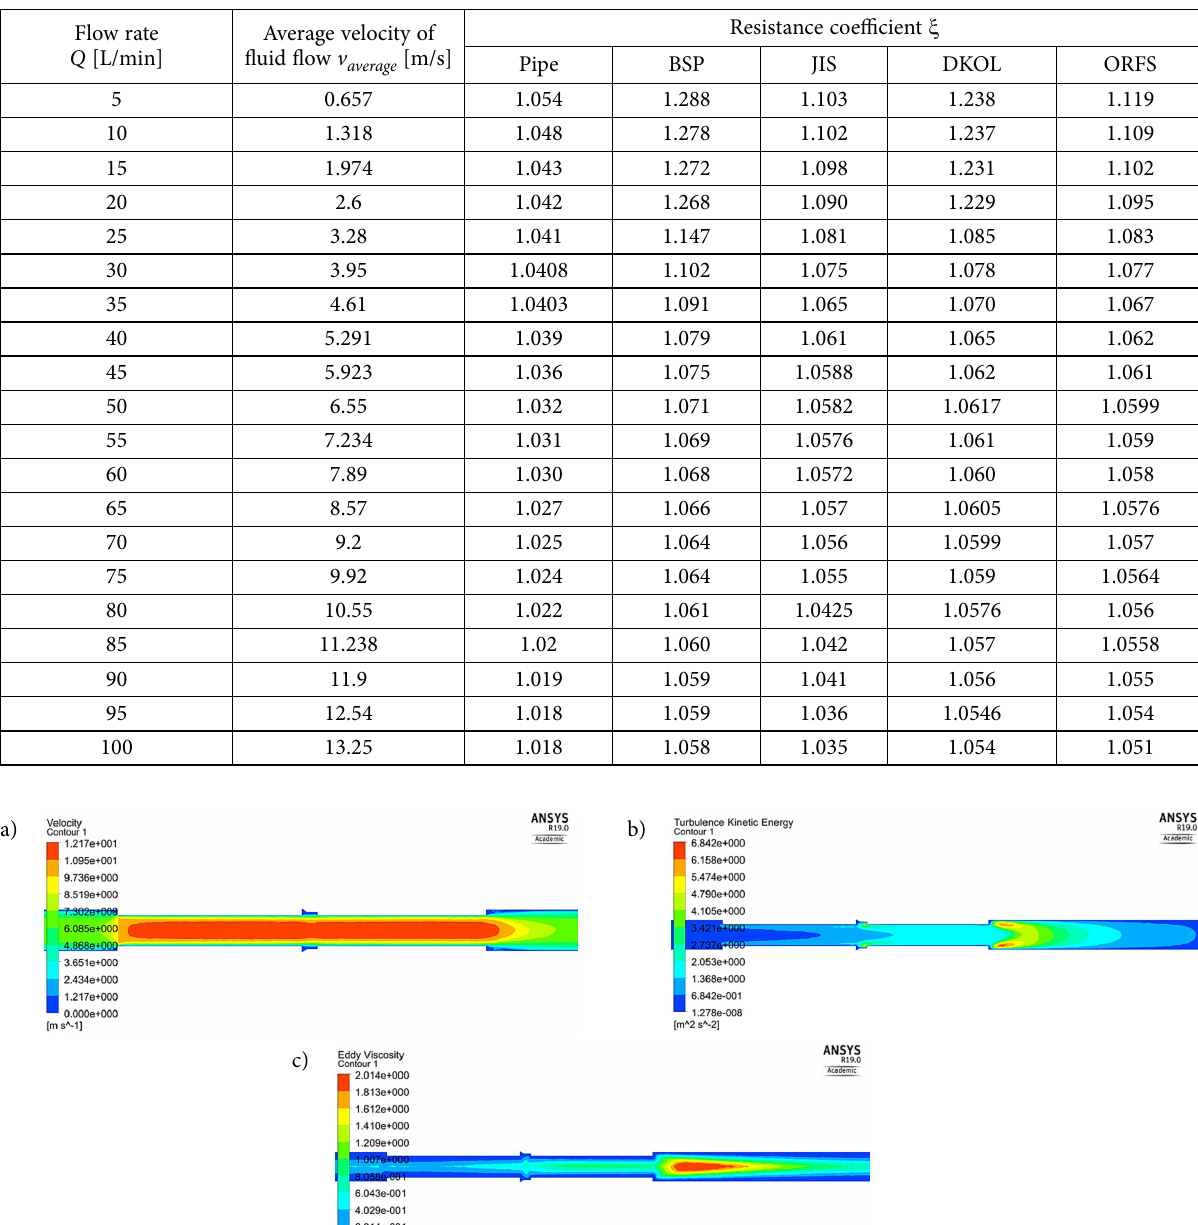
Table 7. The results of fluent simulation (resistance coefficient) Flow rate Average velocity of Q [L/min] fluid flow v average